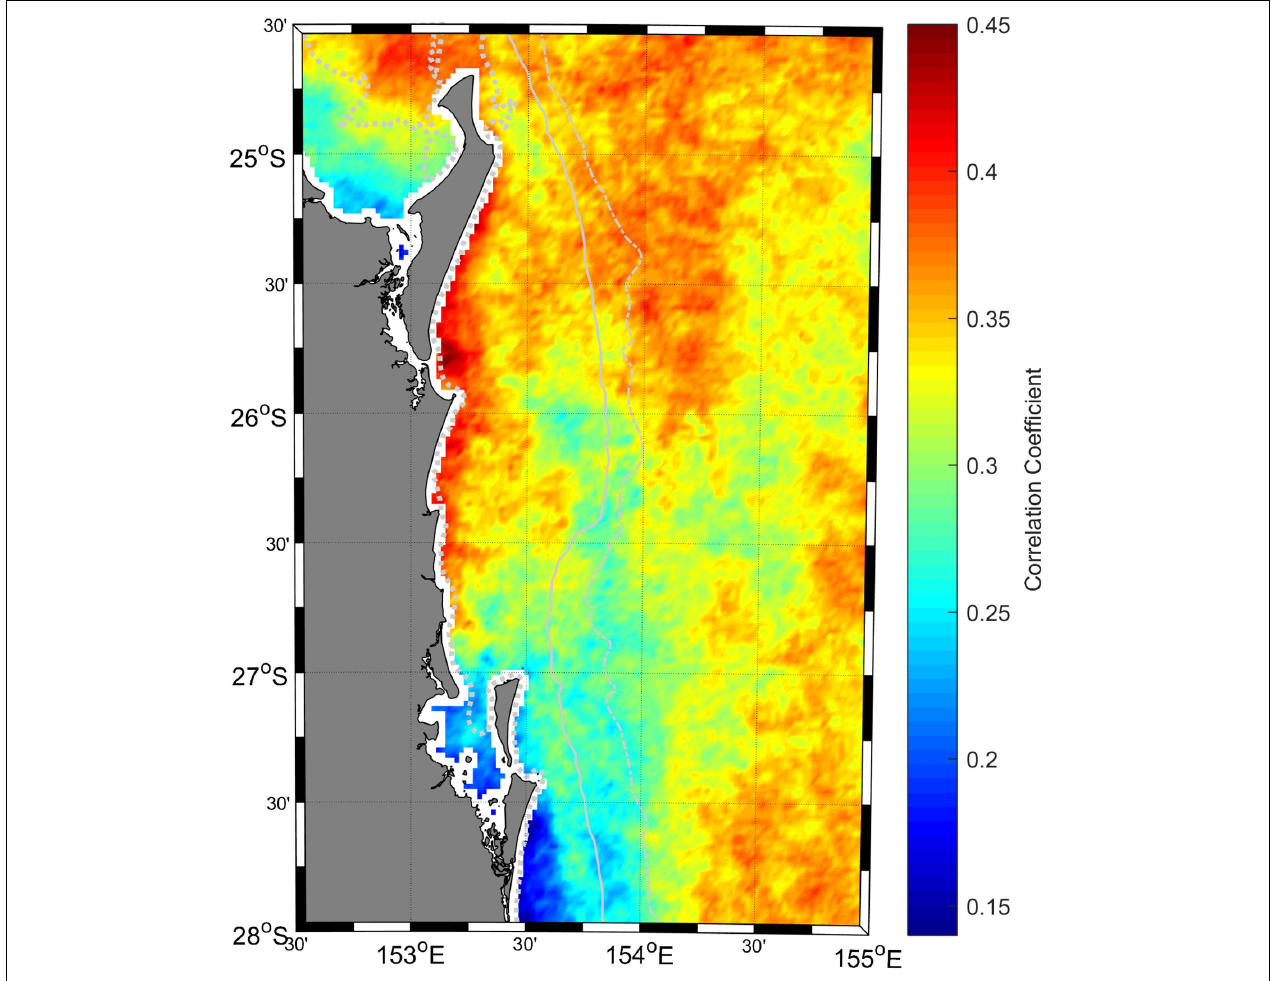
FIGURE 4 | Map of Correlation Coefficients between ONI and